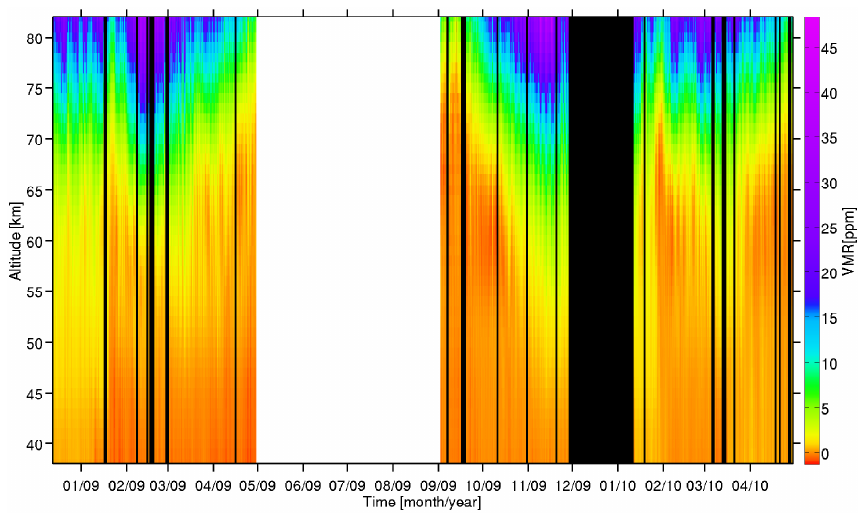
Fig. 9. Time series of the retrieved CO profiles covering the complete analyzed period. The descent of air in fall 2009, the two sudden stratospheric warmings in 2009 and 2010, respectively, as well as the two final warmings in both winters can be easily identified. The black areas mark periods without measurements due to rainy weather or maintenance of the instrument. The white area marks the summer period from which CO measurements can generally not be retrieved reasonably.